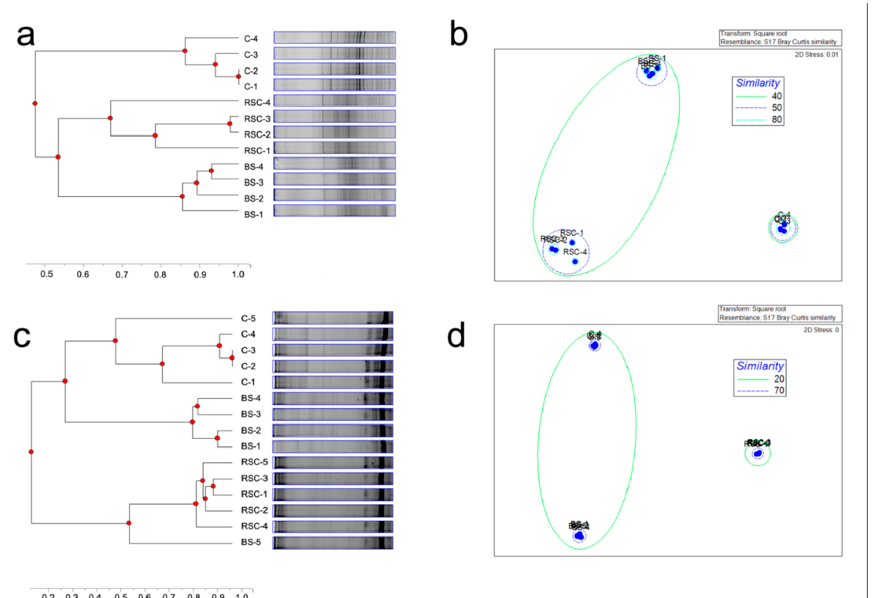
Figure 2. DNA—based profiles of microbial fingerprints determined by denaturing gradient gel electrophoresis (DGGE). ( a ) Dendrogram of bacterial community compositions in samples of compost (C), rhizosphere soil with compost application (RSC) and bulk soil (BS) ( n = 4) revealed by DGGE using 16S rRNA gene as target. ( b ) Non-metric multidimensional scaling (NMDS) of bacterial community compositions revealed by DGGE using 16S rRNA gene as target. ( c ) Dendrogram of fungal community compositions in samples of C, RSC and BS ( n = 4) revealed by DGGE using 18S rRNA gene as target. ( d ) NMDS of fungal community compositions revealed by DGGE using 18S rRNA gene as target.